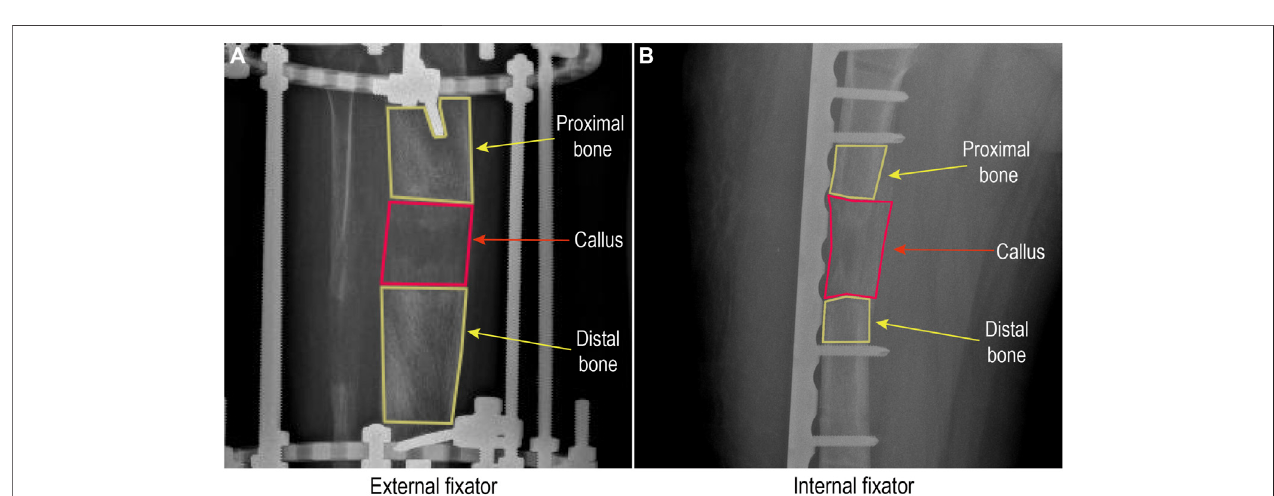
FIGURE 2 | Pixel value assessment from a radiograph in a picture archiving and communication